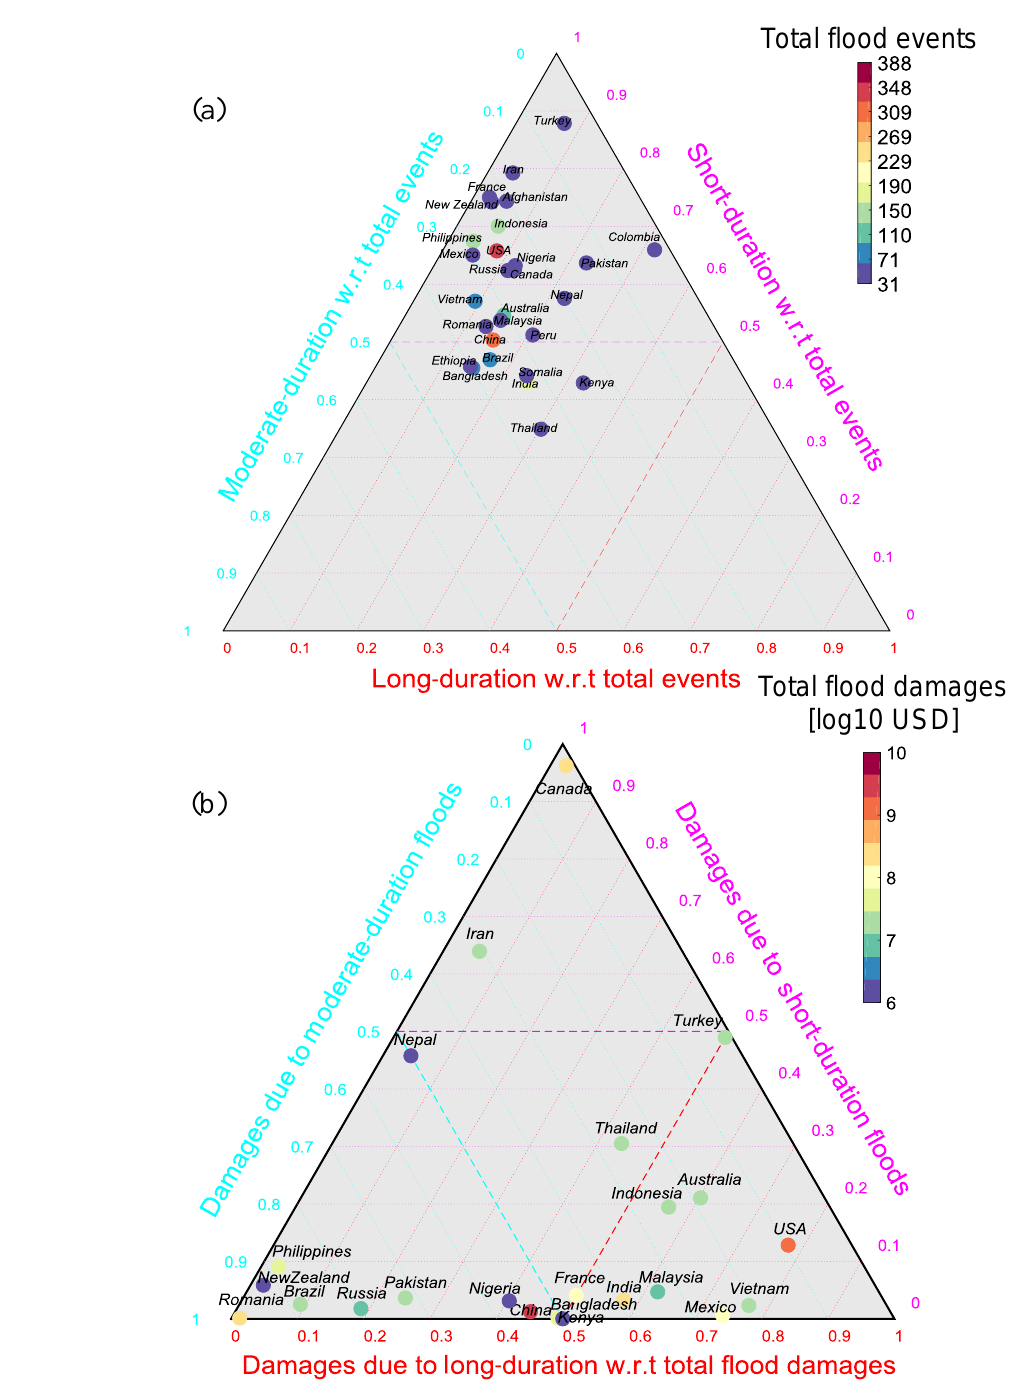
Figure 7. (a) Relative frequency of short- (less than 7 days), moderate- (8 to 20 days), and long-duration (21 days and above) floods for the countries with at least 31 events from 1985 to 2015; (b) relative flood damages due to short-, moderate-, and long-duration floods with respect to total flood damages for the countries with at least 31 events from 1985 to 2015 (except Colombia, Peru, Ethiopia, Somalia, and Afghanistan due to lack of